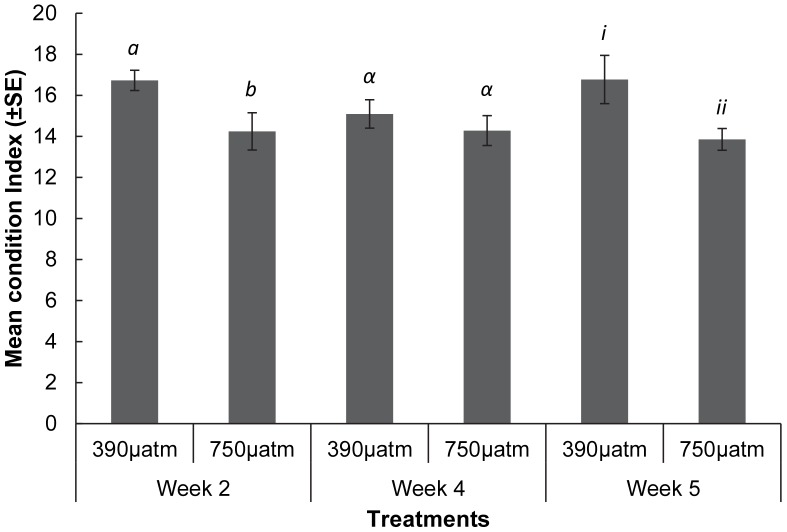
The mean condition index of M. asperrima individuals in response to ambient and elevated pCO2.Mean condition index after exposure to ambient and elevated pCO2 (390 µatm, 750 µatm), for 2, 4 and 5 weeks ±MSE, n = 3. Symbols above columns represent results of SNK tests, Different Latin a - b, Greek α - α, and Roman i - ii symbols represent differences within each sampling time between pCO2 treatments.